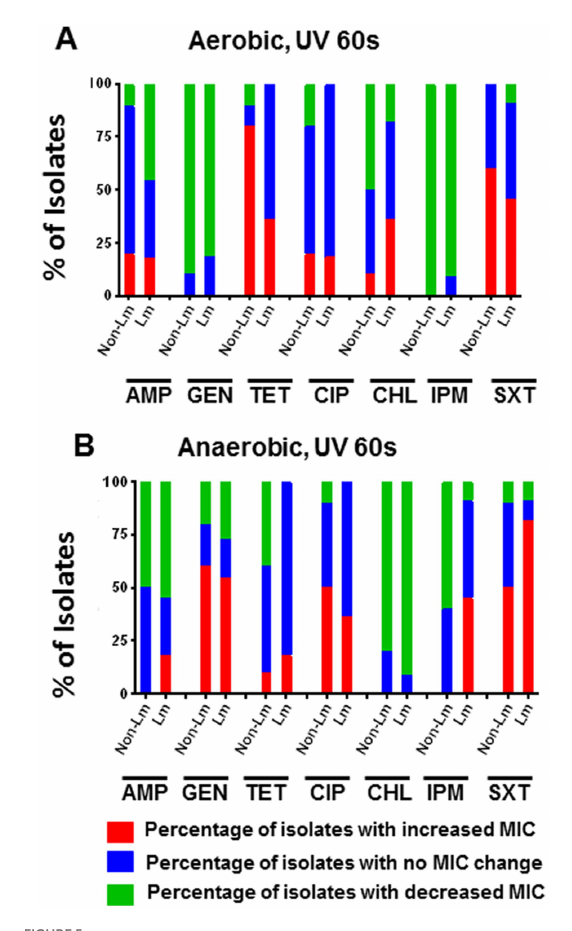
FIGURE 5 Changes in antimicrobial susceptibility in aerobic and anaerobic conditions after UV stress of the 60s. AMP: ampicillin, GEN: gentamicin, TET: tetracycline, CIP: ciprofloxacin, CHL: chloramphenicol, IPM: imipenem, SXT: trimethoprim- sulfamethoxazole. (A) Change of MIC (increase/decrease) after UV stress compared with pre-stress (before stress) under aerobic incubation. (B) Change of MIC (increase/decrease) after UV stress compared with pre-stress (before stress) under anaerobic incubations.